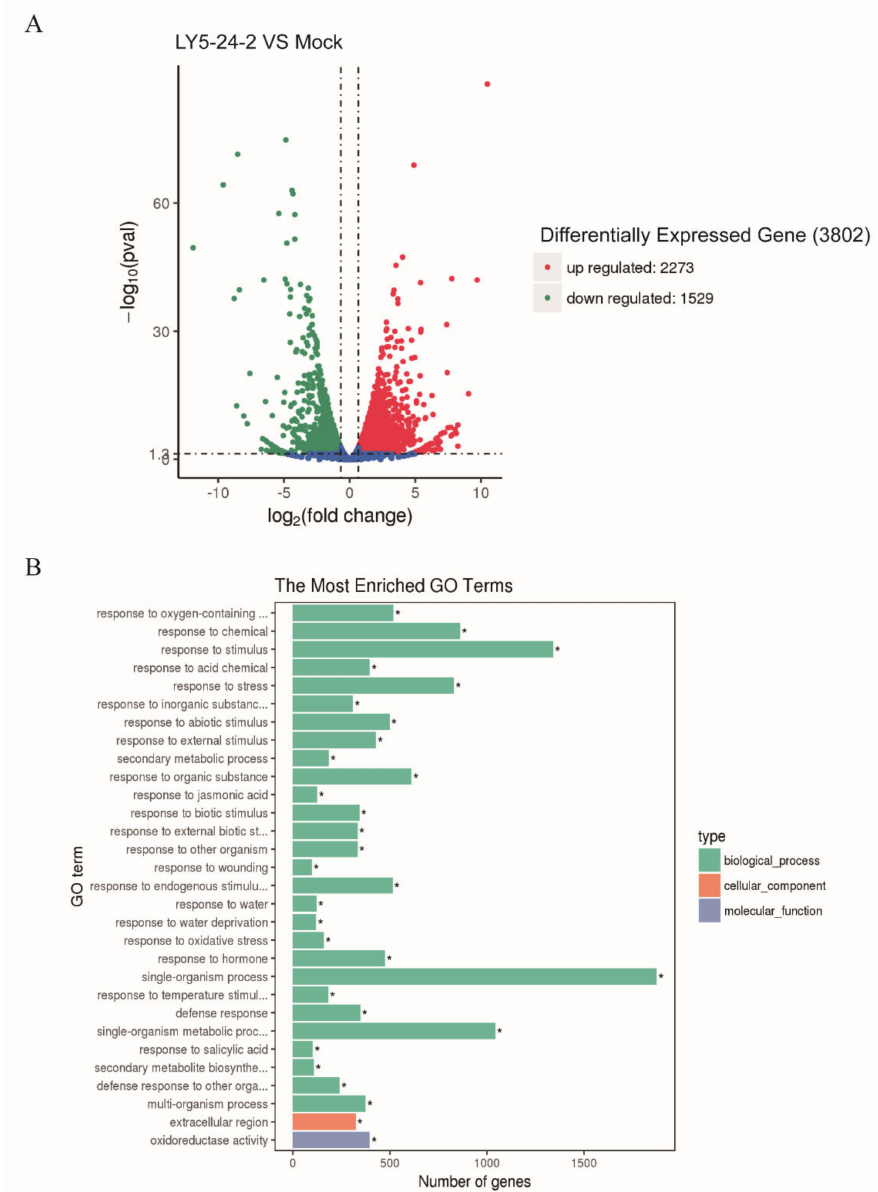
Figure 5. Identification of differentially expressed genes (DEGs) and GO enrichment analysis of A. thaliana after a LY5-24-2-treatment. ( A ) Identification of DEGs of A. thaliana from the LY5-24-2 treatment and the control ( p < 0.05). ( B ) GO enrichment analysis of DEGs in A. thaliana after a LY5-24-2 treatment (* p < 0.05, Student’s t